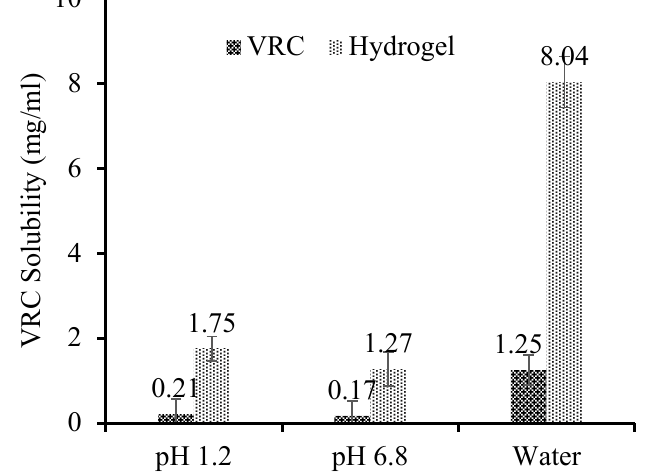
Figure 1. Solubility studies at pH 1.2, pH 7,4, and in water (CDN5) (Mean ± SD, n = 5).